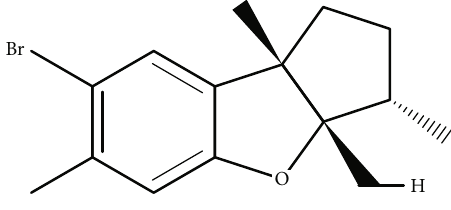
Figure 1: Chemical structure of